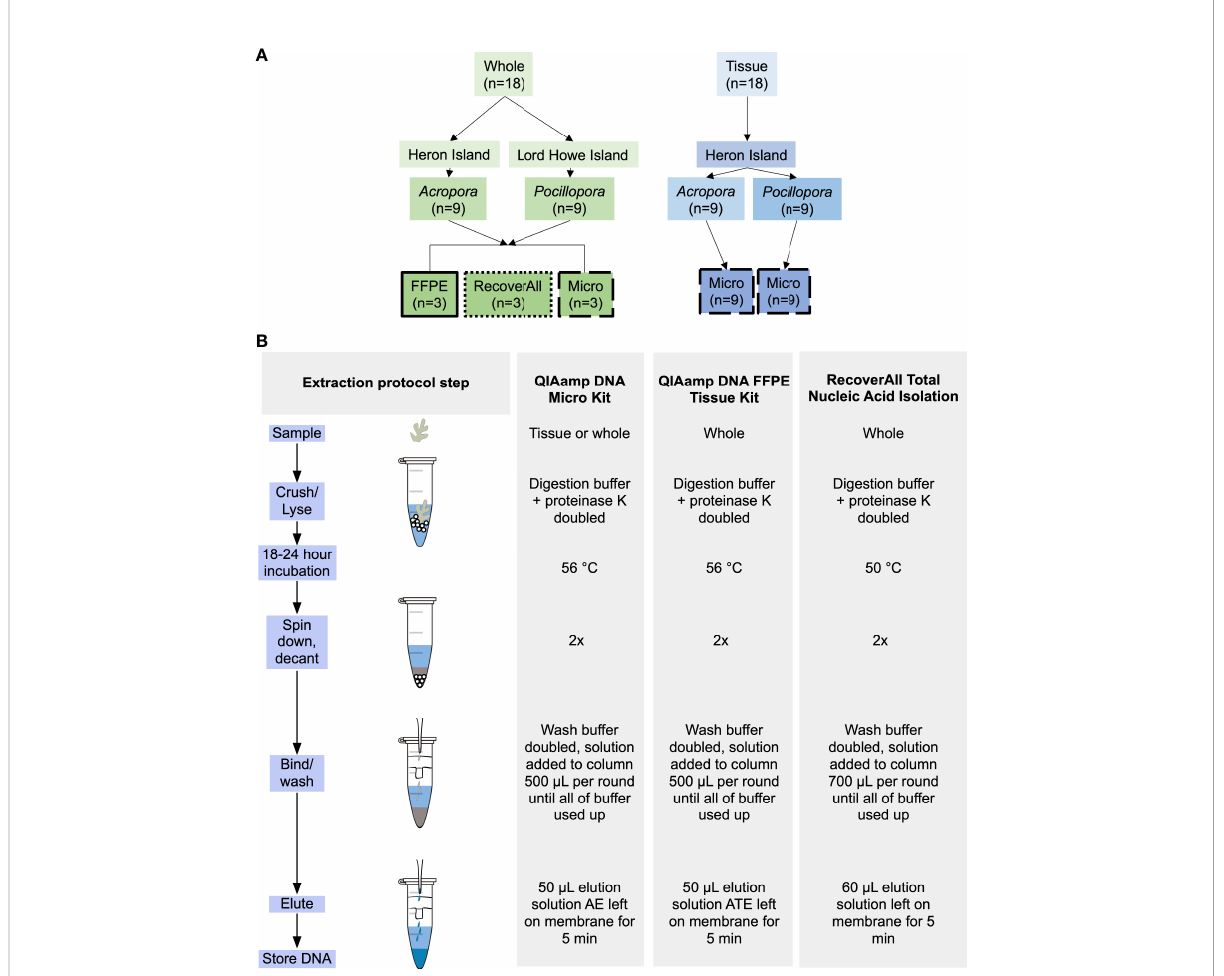
FIGURE 1 Schematics of (A) experimental design: highlighting sample type, species, and extraction protocol, and (B) extraction protocols used in the present study: highlighting subtle differences in methodologies between